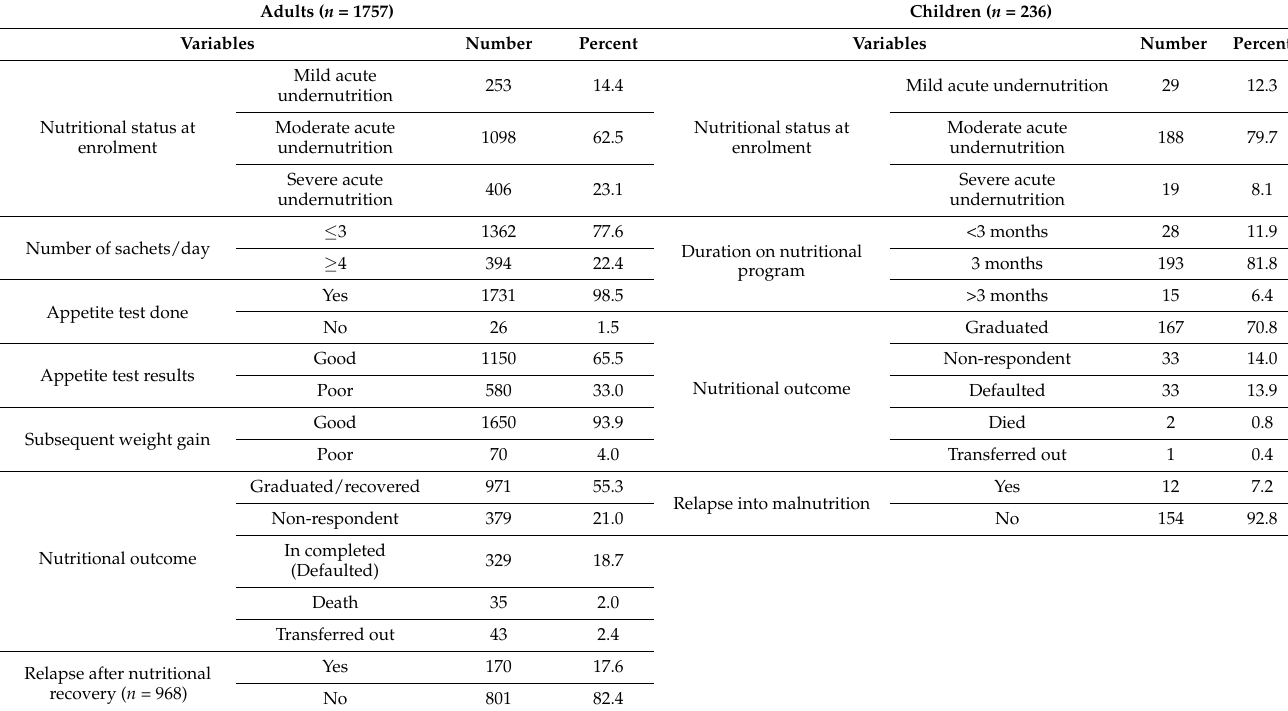
Table 3. Nutritional characteristics of adults and children enrolled in the nutritional